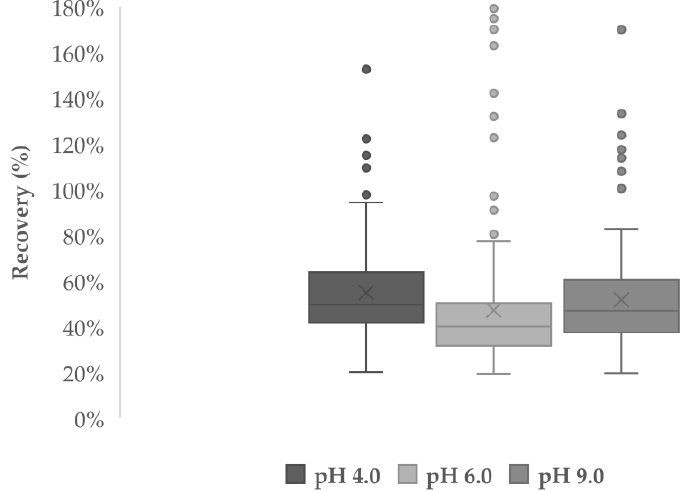
Figure 1. Boxplots of the recoveries (%) for Oasis HLB clean-up at pH 4.0, 6.0 and 9.0, showing minimum and maximum values (whiskers), percentiles (Q 1 and Q 3 ), average (x), median (line) and outliers (points).